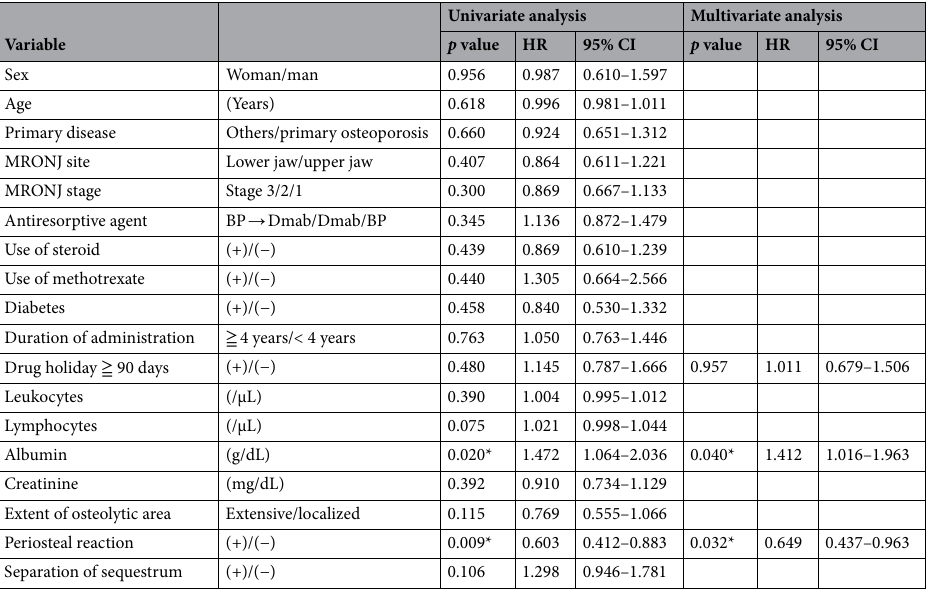
Table 4. Relationship between each variable and treatment outcome (univariate and multivariate cox regression). *Significant. BP: bisphosphonate, Dmab: denosumab, HR: hazard ratio, 95% CI: 95% confidence